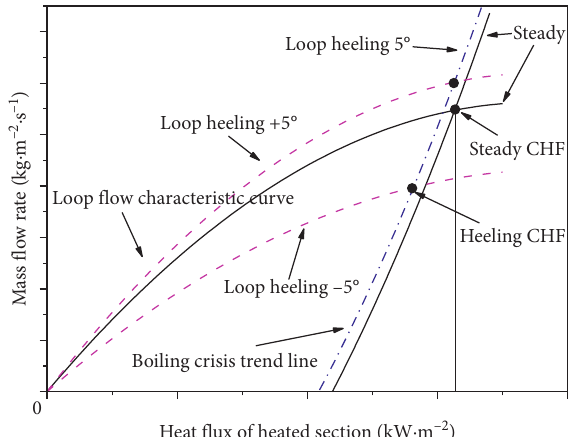
Figure 10: Influence of